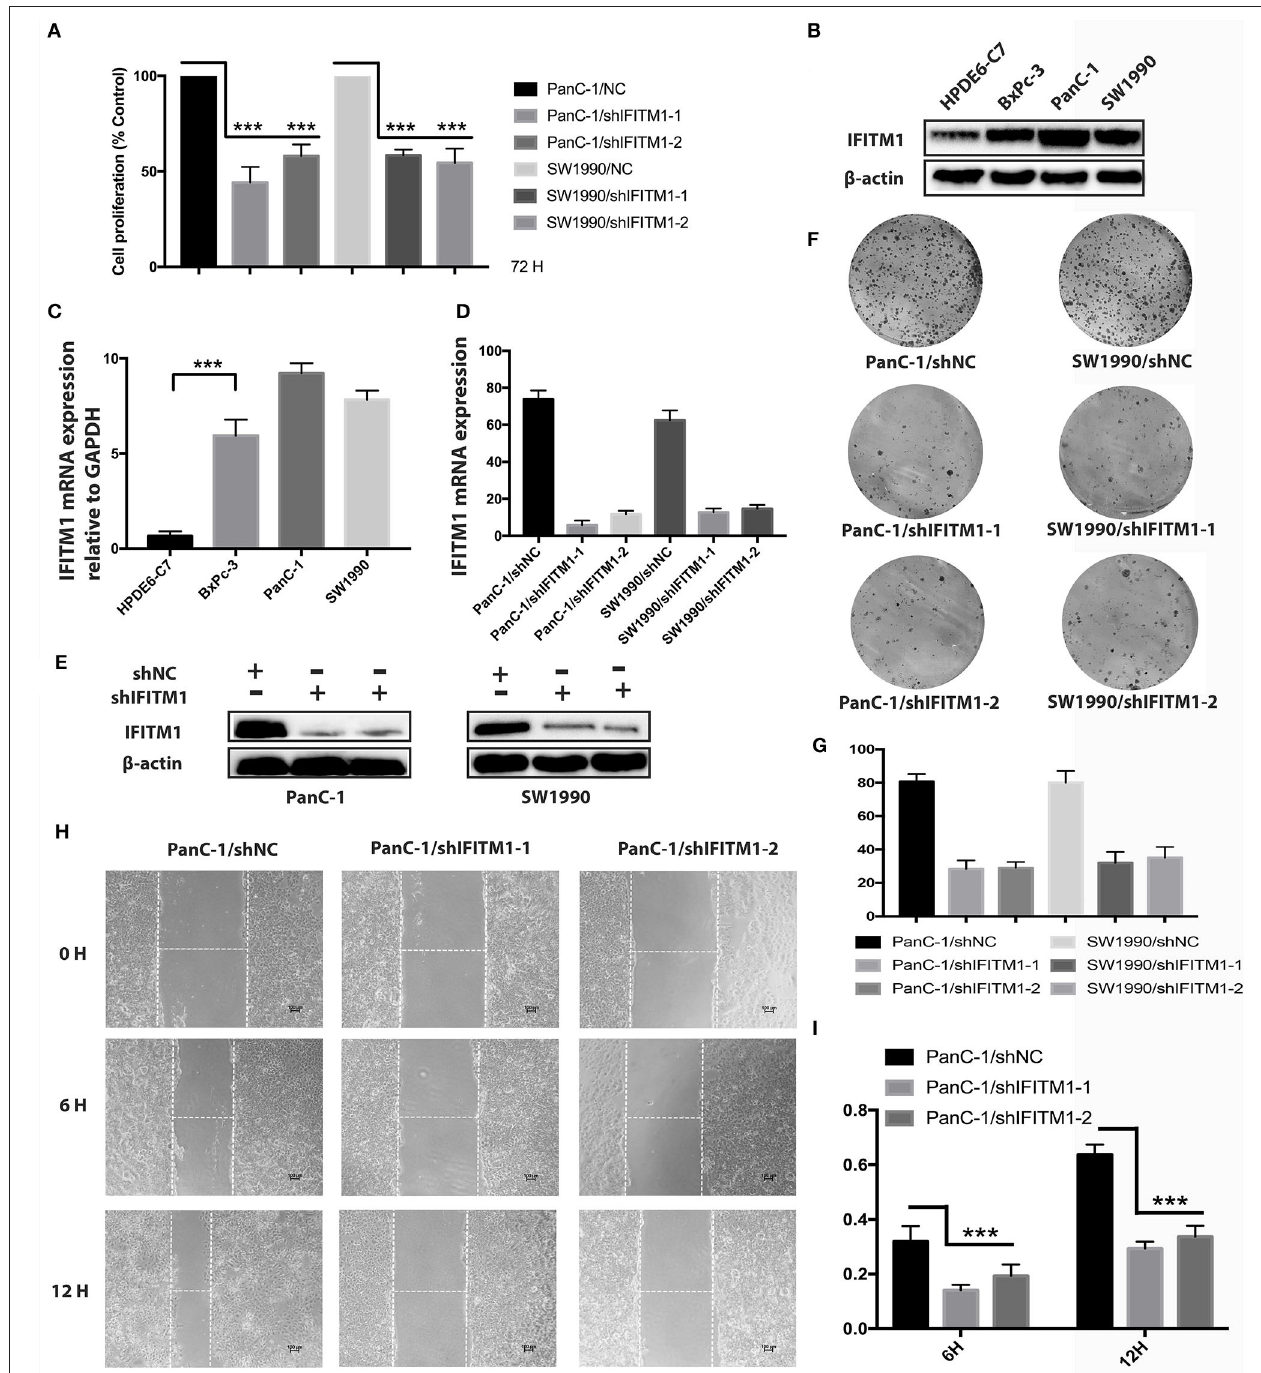
FIGURE 8 | The depletion of IFITM1 decreased the tumorigenicity of pancreatic cancer cells. (A) Control (shNC) or IFITM1-depleted (shIFITM1-1 and shIFITM1-2) PanC-1 and SW1990 cell lines were incubated for 72h to determine the cell proliferation rate by cell counting kit-8 assay. Data represent the mean ± SD of three independent experiments (*** p < 0.001). (B,C) Detection of IFITM1 mRNA expression in three different pancreatic cancer cell lines and HPDE6-C7 by qRT-PCR and Western blot analysis. GAPDH and β -Actin were used as controls, respectively. The results are expressed as the mean ± SD of three independent experiments (*** p < 0.001). (D,E) Pancreatic cancer cell lines were transfected with shRNAs (shIFITM1-1 and shIFITM1-2), and the expression level of IFITM1 was assessed by qRT-PCR and Western blot analysis using GAPDH and β -actin as controls, respectively. The results are expressed as mean ± SD of three independent experiments. (F,G) Colony-formation assay was performed to show decreased cancer stem cell-like properties of PanC-1 and SW1990 cells transfected with shIFITM1-1 or shIFITM1-2 compared with control in vitro . (H,I) The wound-healing assay was performed to assess the effect of IFITM1 silencing on the wound closure ability of PanC-1 cells. Representative images are shown (magnification ×